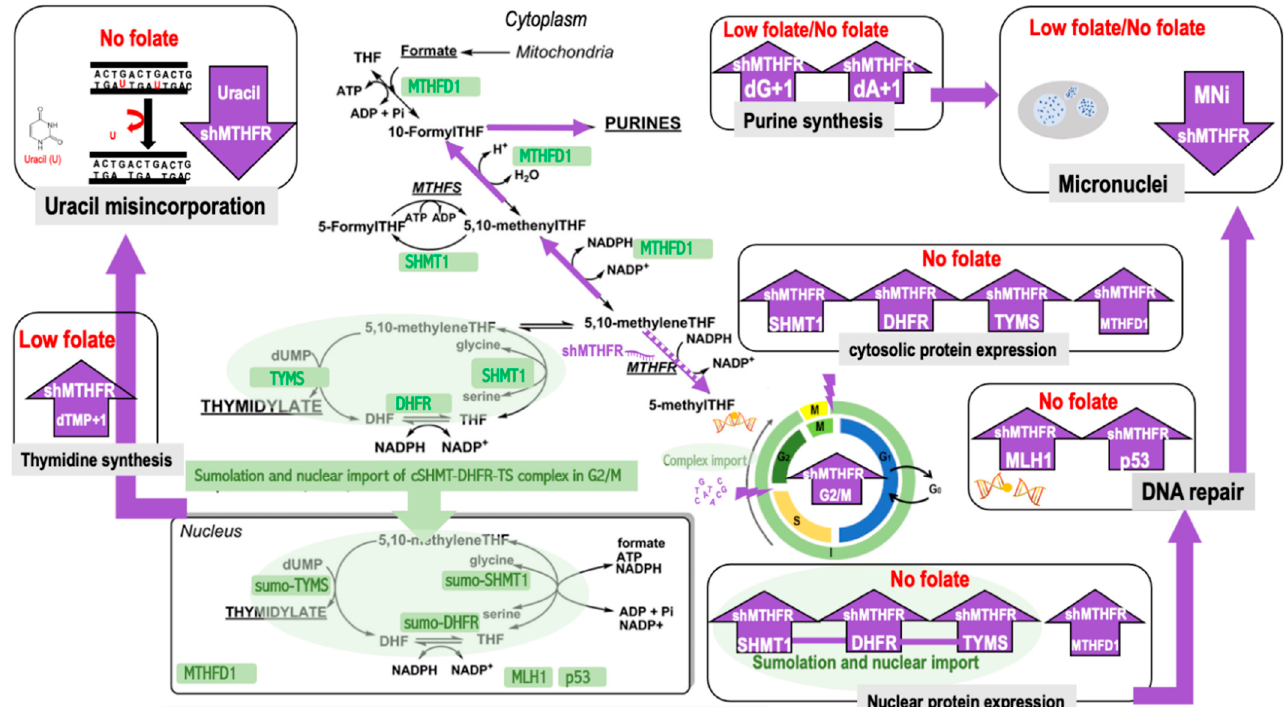
Figure 4. MTHFR knockdown by shRNA can protect DNA under folate deficiency. Lower MTHFR is associated with increased proportional cell populations in the G2/M phase, increased cytosol, and nuclear SHMT1/DHFR/TYMS protein expression under folate deficiency. shMTHFR assisted purine synthesis in HepG2 cells under folate deficiency and such impacts were amplified after folinate supplementation. shMTHFR promoted nuclear MLH1/p53 expression under folate deficiency that can protect cells from folate depletion induced micronuclei and uracil misincorporation. Abbreviations: MTHFD1, methylenetetrahydrofolate dehydrogenase; SHMT, serine hydroxymethyltransferase; MTHFR, methylenetet- rahydrofolate reductase; GNMT, glycine N-methyltransferase; MTR, methionine synthase; MAT, S -adenosylmethionine synthase; SAHH, S-adenosylhomocysteinehydrolase; TS, thymidylate synthase; DHFR, dihydrofolate reductase; THF, tet- rahydrofolate; dUMP, deoxyuridine monophosphate; DHF, dihydrofolate; hMLH1: Human Mut L homologue-1 (hMLH1).